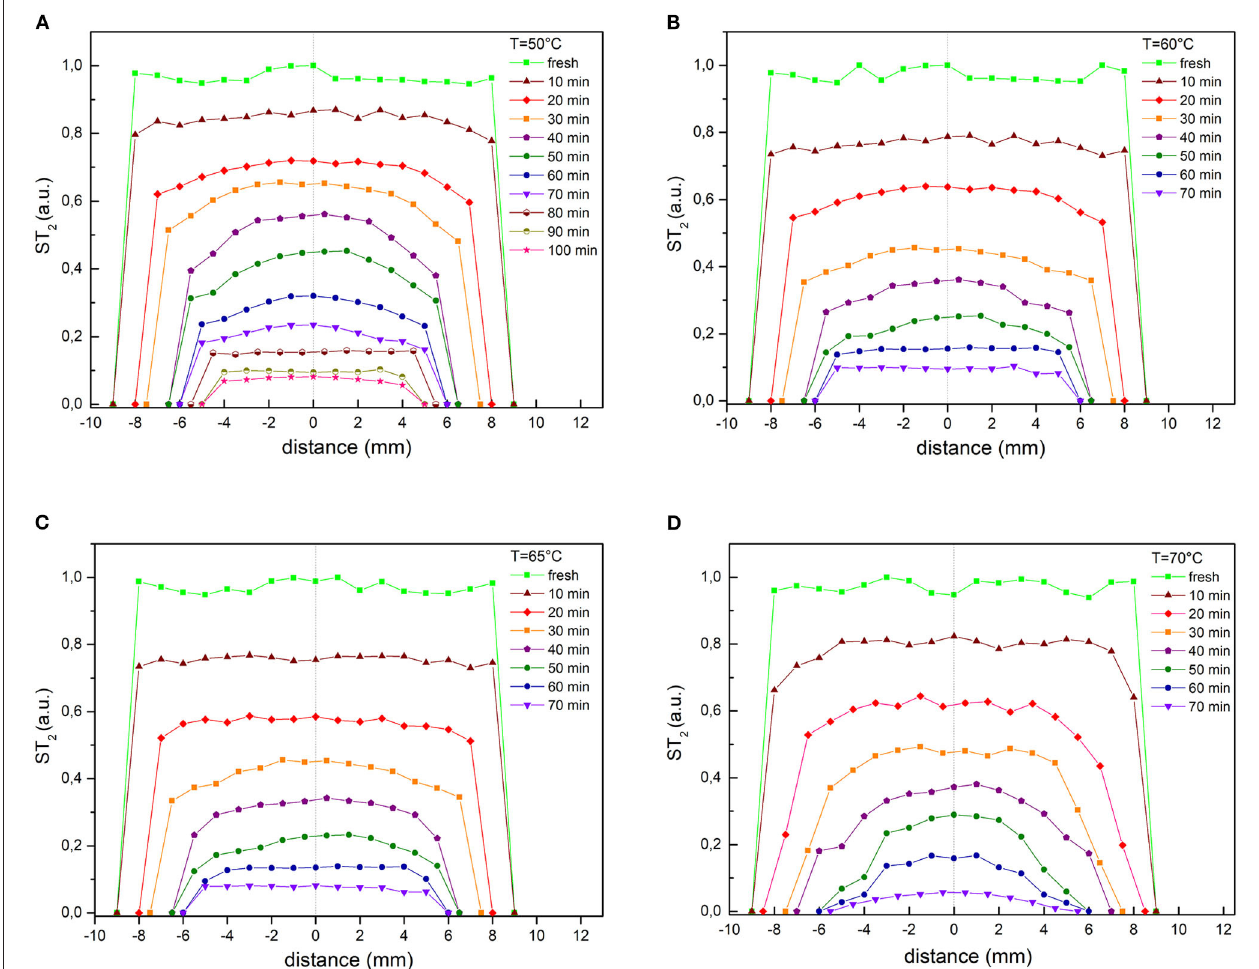
FIGURE 4 | Transverse profiles of normalized T 2 taken slice by slice for selected drying times at all temperatures considered: (A) 50 ◦ C, (B) 60 ◦ C, (C) 65 ◦ C, (D) 70 ◦ C.